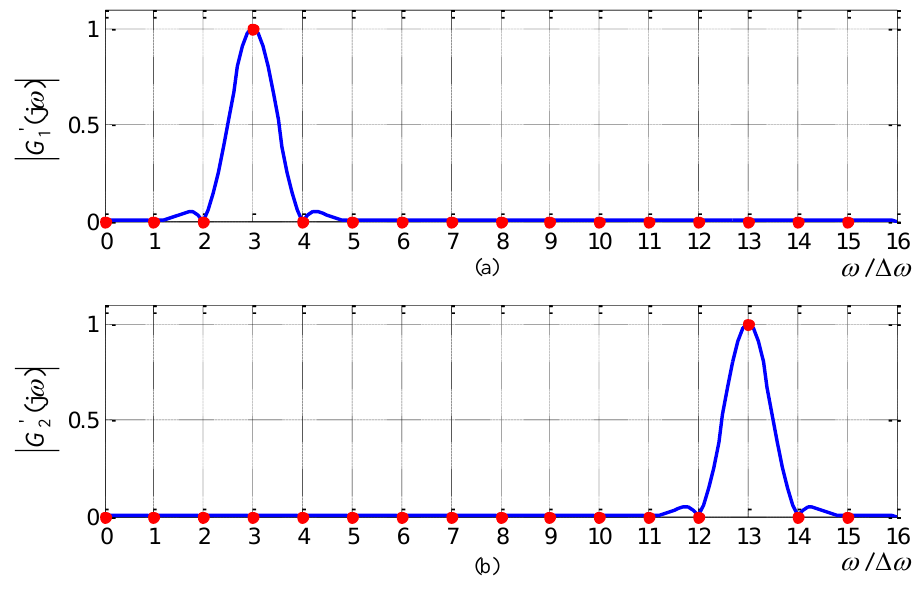
Figure 4. Transfer curves of two sub-filters ( N = 16, m = 3): ( a ) sub-filter g (cid:48) From Figure 4, one can observe that | G (cid:48) the closed-formed formula in (16)) strictly pass through the specified frequency points at 3 ∆ ω and 13 ∆ ω , respectively. Meanwhile, as Figure 4 illustrates, | G (cid:48) symmetric with ω = π